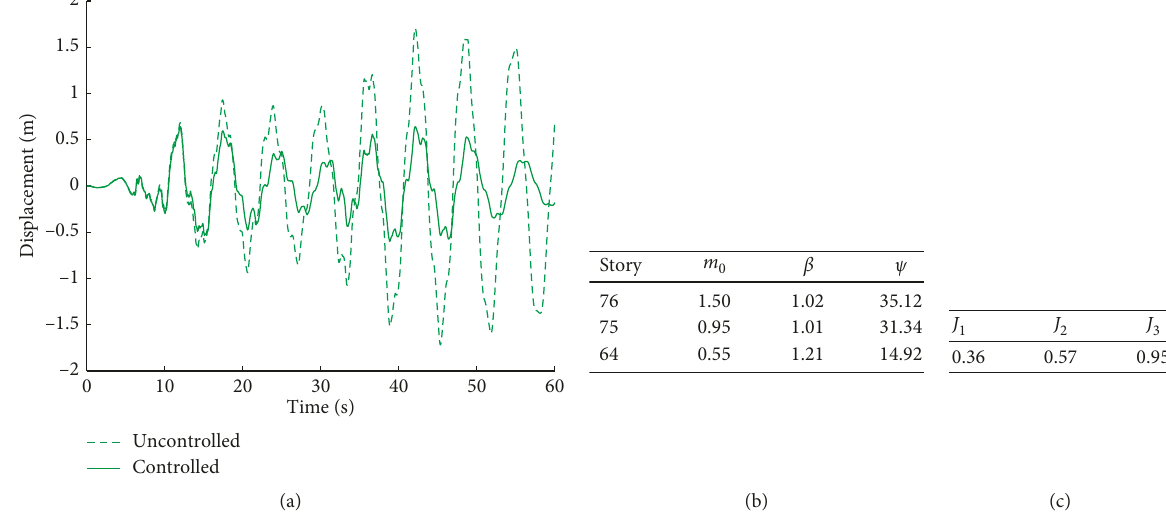
Figure 15: Uncontrolled/controlled responses under the Manjil earthquake. (a) Roof displacement response. (b) TMD specifications. (c) Objective